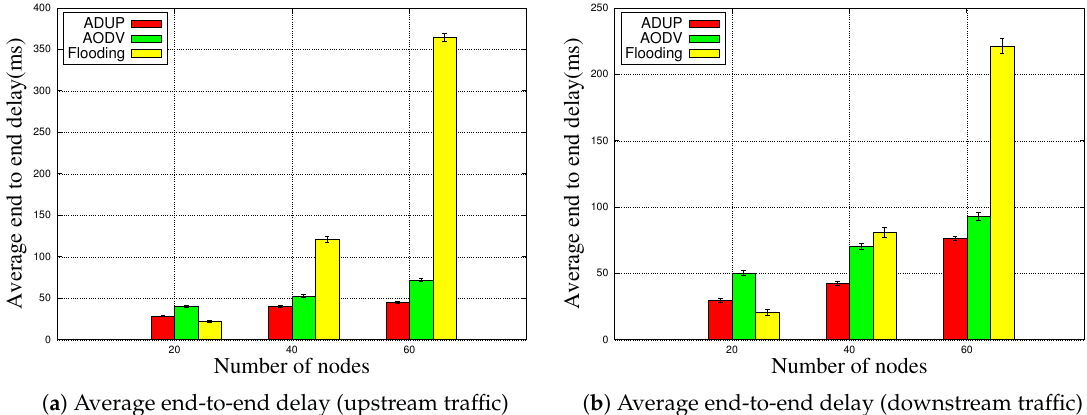
Figure 7. Average end-to-end